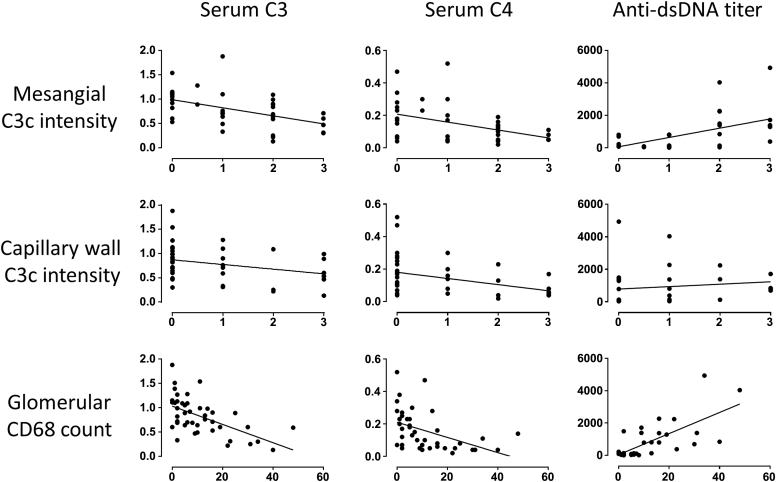
Correlation of glomerular complement C3c staining intensity and maximum glomerular CD68 count with serum C3, serum C4, and anti–double-stranded DNA (dsDNA) titer. Mesangial C3c staining intensity correlated significantly with serum C3 (r = −0.53, P < 0.001), serum C4 (r = −0.44, P = 0.004), and dsDNA (r = 0.53, P = 0.003). Capillary wall C3c staining intensity correlated significantly with serum C3 (r = −0.49, P = 0.001), serum C4 (r = −0.56, P = 0.0001), and dsDNA (r = 0.43, P = 0.017). Maximum glomerular CD68 count correlated significantly with serum C3 (r = −0.64, P < 0.00001), serum C4 (r = −0.61, P < 0.0001), and dsDNA (r = 0.78, P < 0.000001).